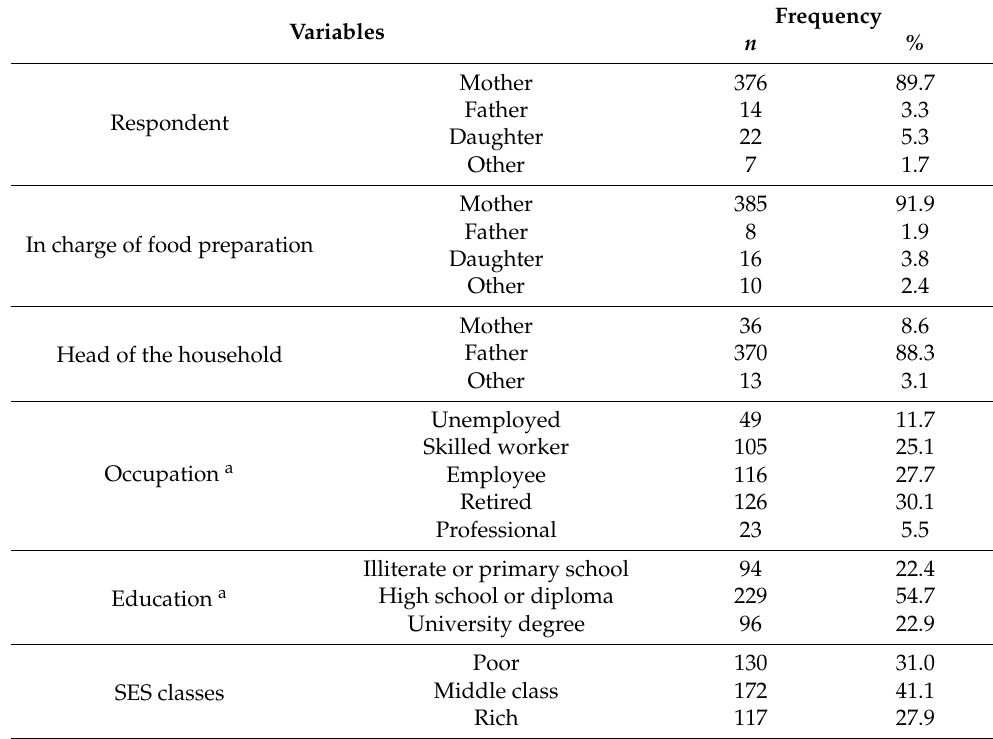
Table 2. Demographic and socioeconomic summary of the studied households (n = 419).